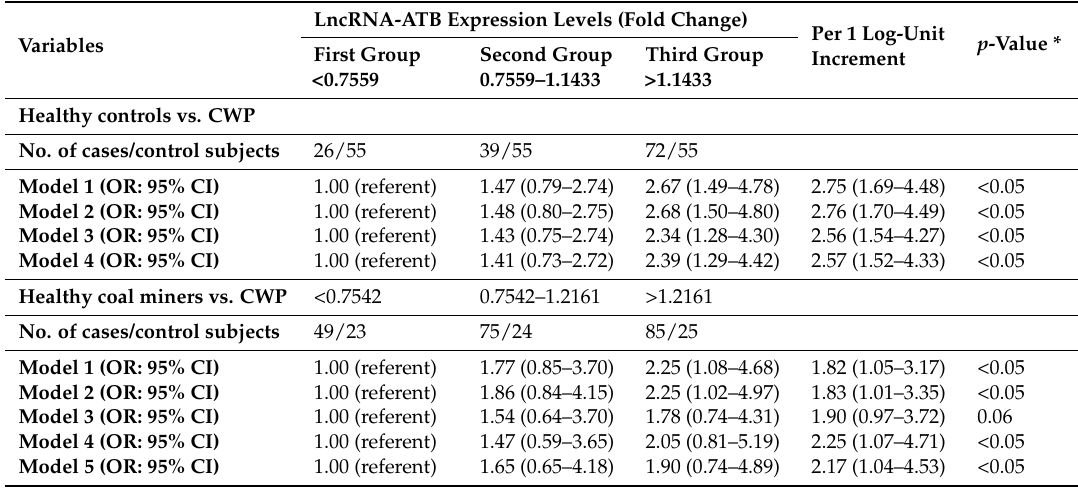
Table 2. Odds ratio of coal workers’ pneumoconiosis (CWP) according to the lncRNA-ATB expression.